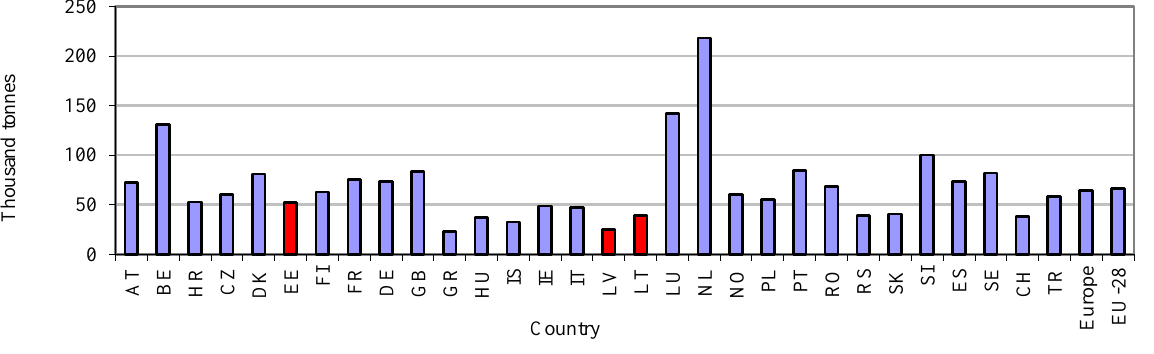
Figure 5. The average amount of asphalt mixture annually produced in a single AMP.